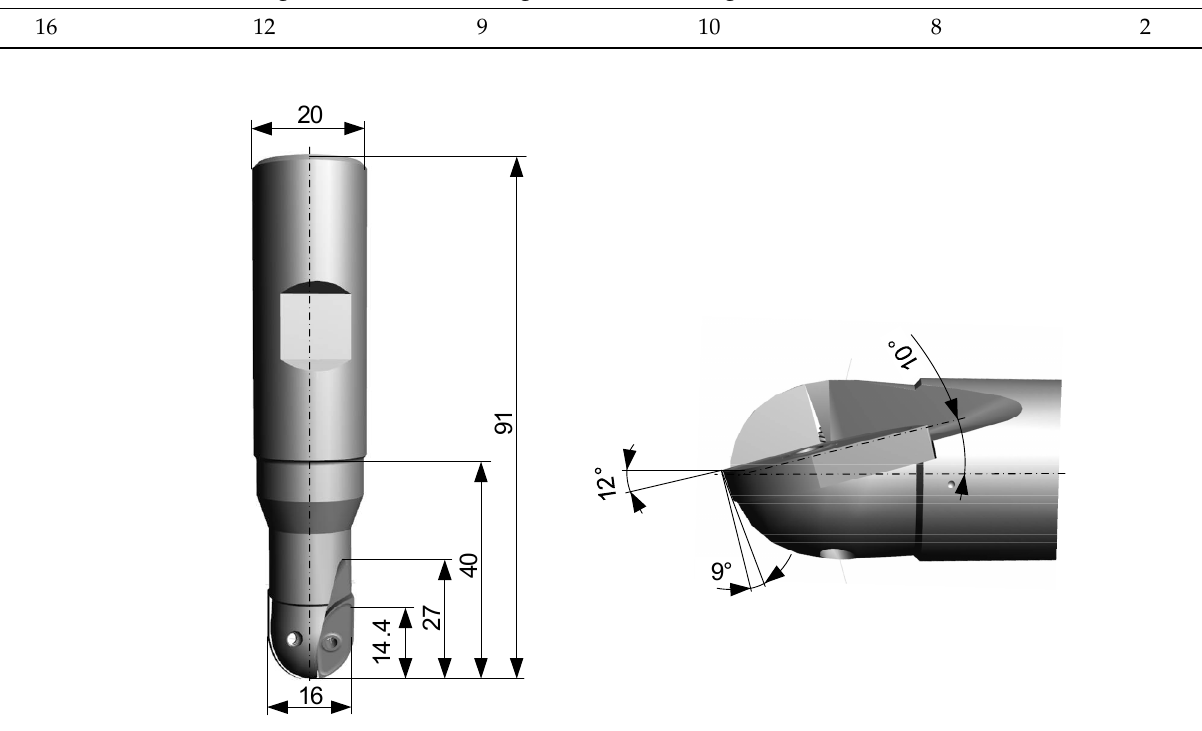
Figure 7. Geometry of ball-end milling cutter.